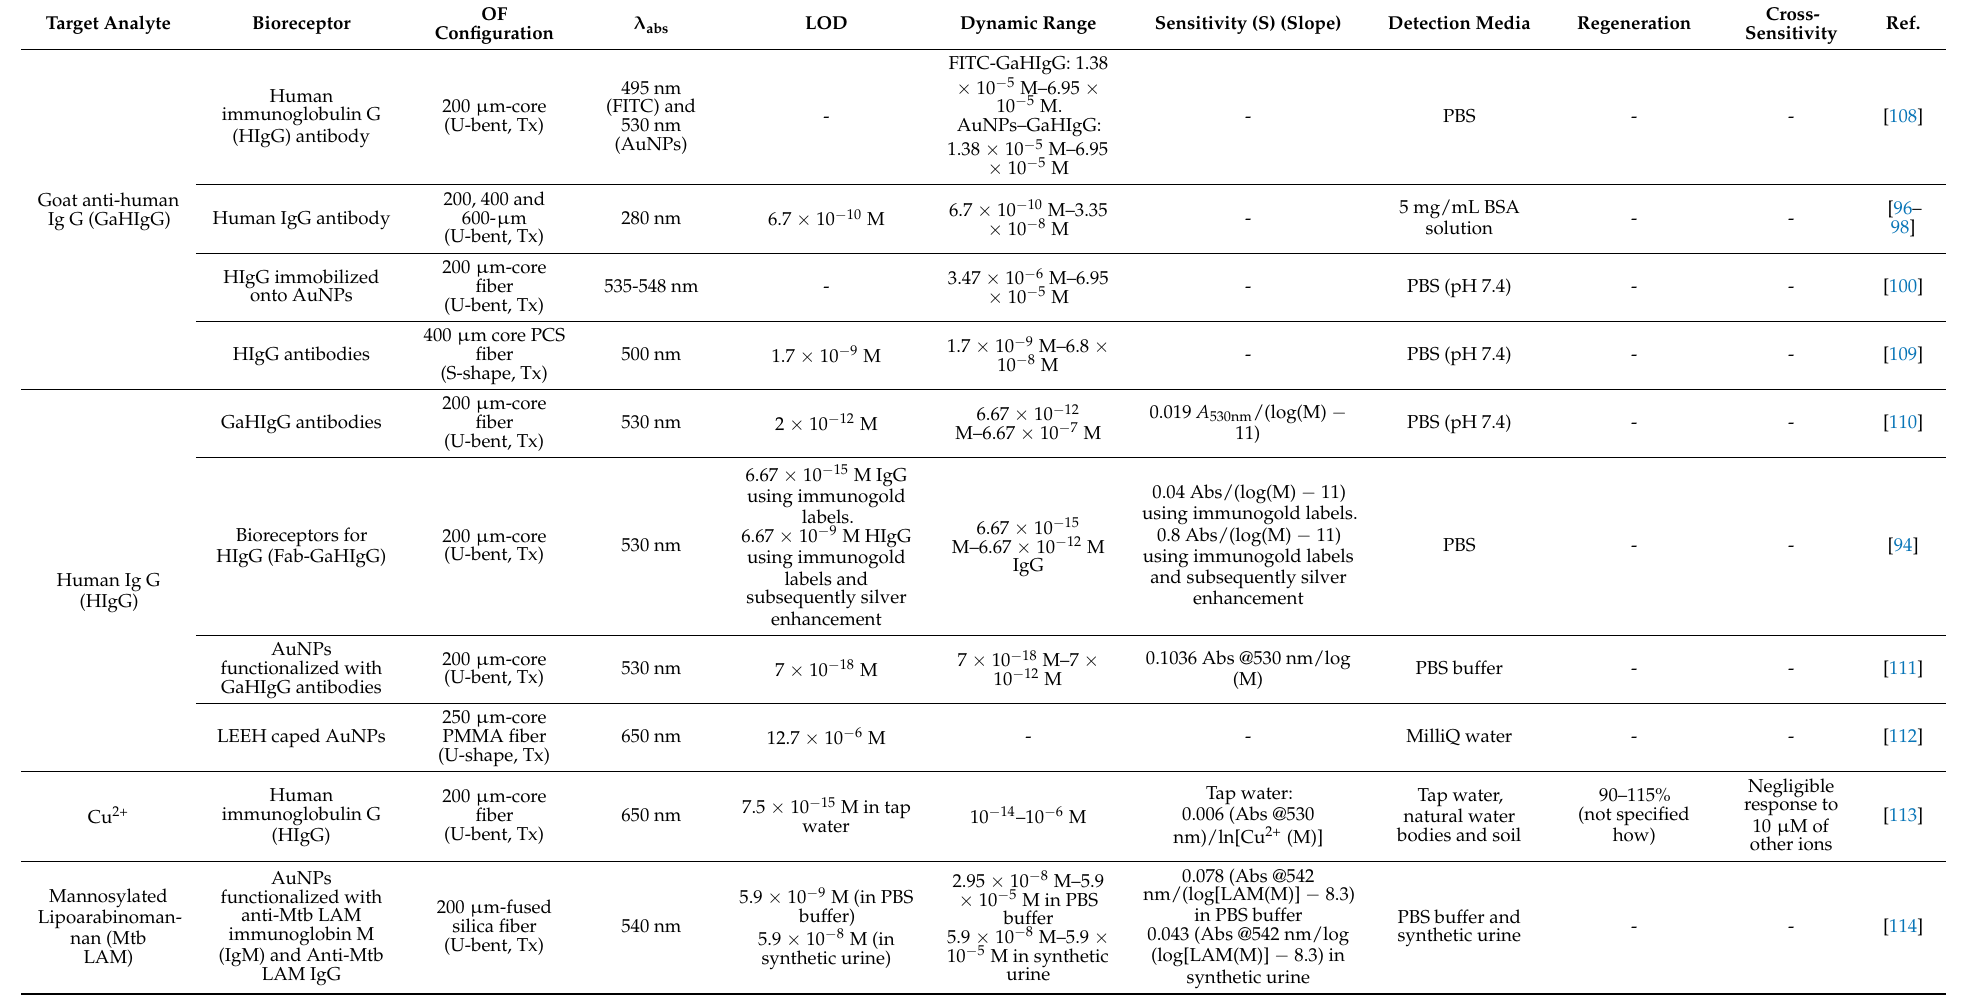
Table 5. Optical fiber biosensors based on absorption using IgG or HIgG antibodies as bioreceptors. The dash indicates that information about that parameter is not available in the original